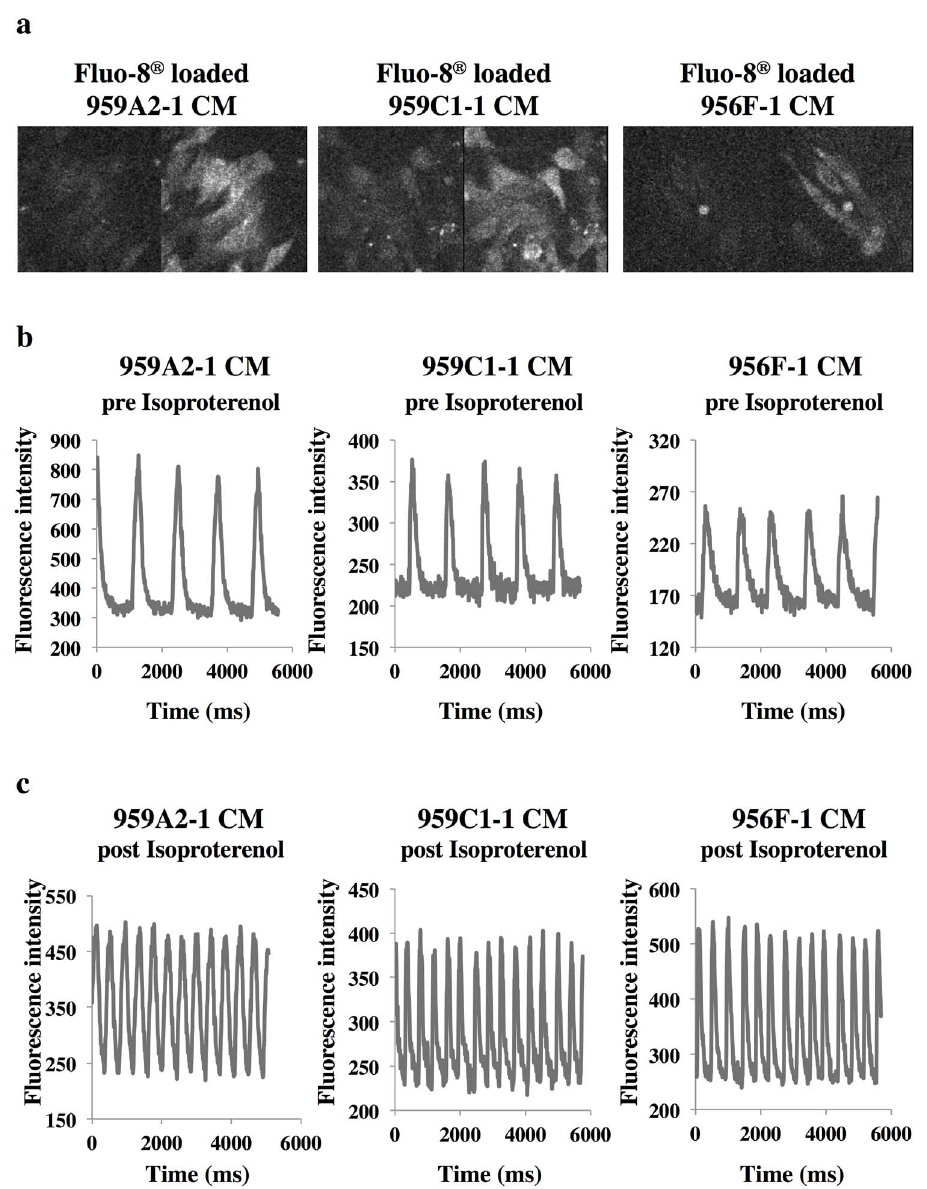
Figure 3. Ca 2 + transient measurement of iPSC-CMs pre and post the administration of isoproterenol. (a) Fluo-8 loaded iPSC-CMs at the time of low (left) and high (right) fluorescence. (b), (c) Sequentially measured fluorescence intensity of Fluo-8 loaded iPSC-CMs pre (b) and post (c) the administration of 1 m M isoproterenol.